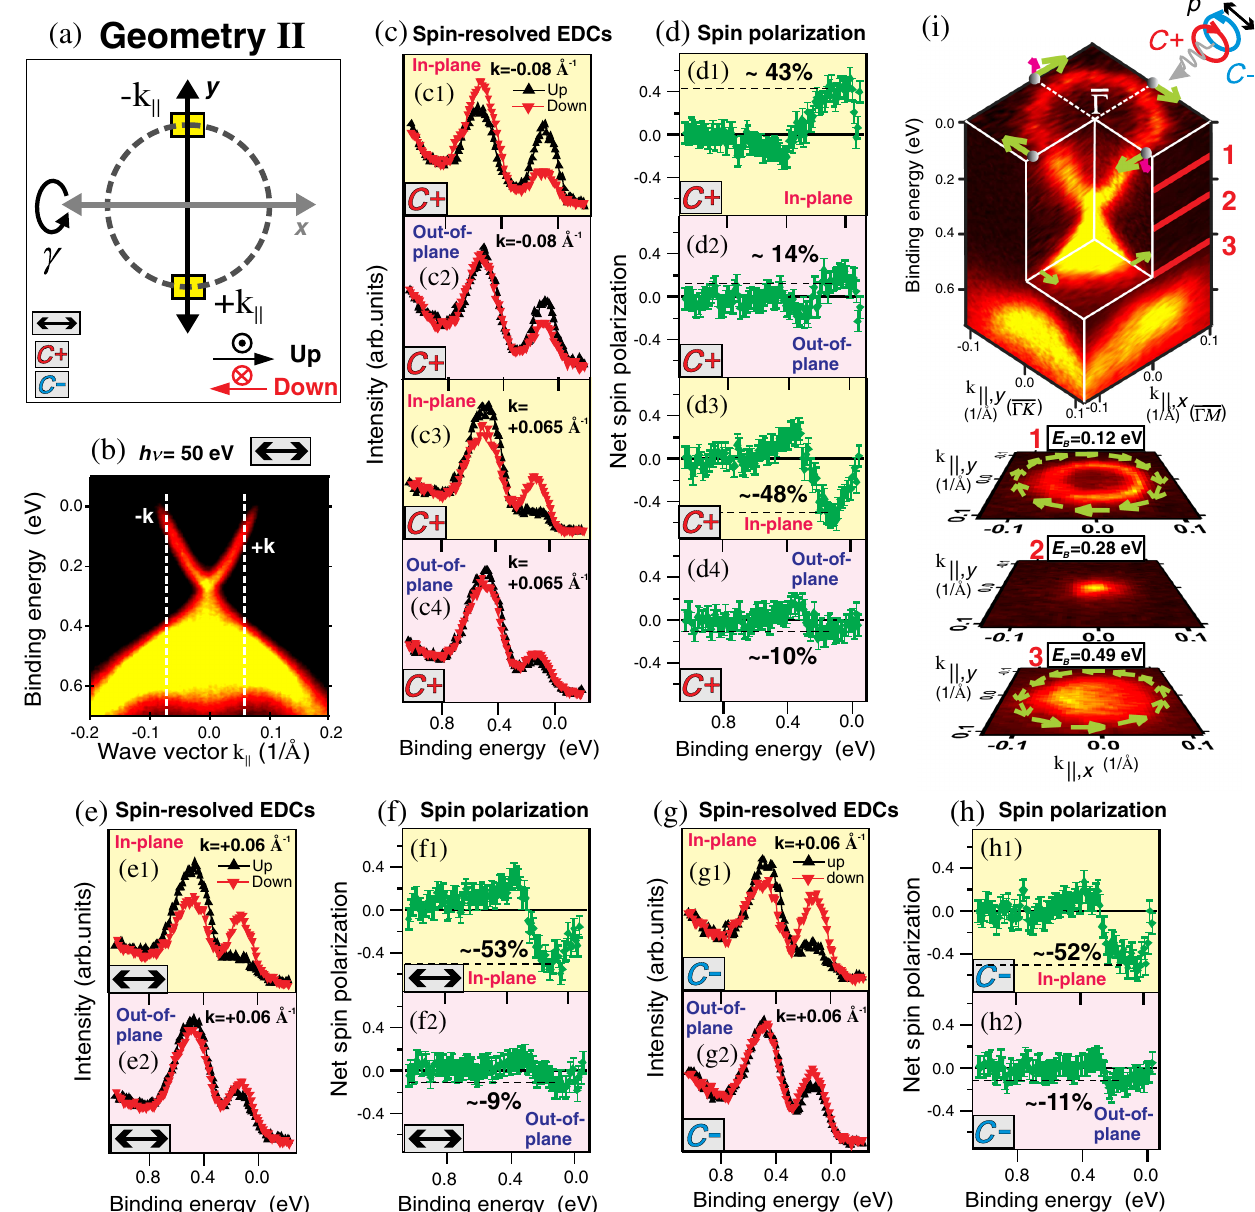
FIG. 2. In-plane and out-of-plane spin polarizations from the TSS measured at 50 eV using (a) geometry II (where the tilt angle γ of the sample is changed) as well as different light polarizations. The dotted circle represents an ideal Dirac cone, and the yellow rectangles represent momentum regions where the SR-ARPES measurements have been taken. (b) ARPES intensity obtained with linear p -polarized light. (c),(e),(g) In-plane [(c1),(c3),(e1),(g1)] and out-of-plane [(c2),(c4),(e2),(g2)] spin- resolved EDCs measured for various k ∥ wave vectors [marked by dashed white lines in (b)]. The in-plane (out-of-plane) spin direction is given in (a). The red (black) arrow in (a) indicates the in-plane up (down) spin direction, and the black dot (red cross) the spin direction parallel (antiparallel) to the surface normal. (d),(f),(h) To the right of each spin-resolved EDC, the corresponding net spin polarizations are shown. (i) Summary of the results from SR-ARPES measurements at 50 eV. Top: The helical spin texture is probed in four k ∥ directions ( (cid:1) Γ K and (cid:1) Γ M ). The Fermi surface exhibits a small distortion due to hexagonal warping. The in-plane (green arrows) and out-of-plane (pink arrows) photoelectron spin directions are in vector and magnitude independent of the light polarization. Bottom: Schematics of the observed in-plane helical spin texture superimposed on constant-energy surfaces extracted from the data shown at the